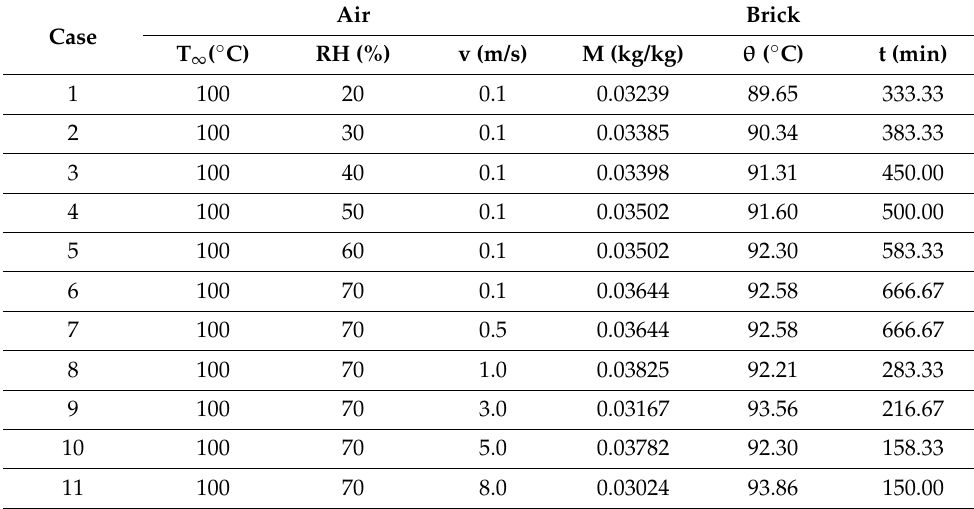
Table 9. Brick conditions at the end of the drying